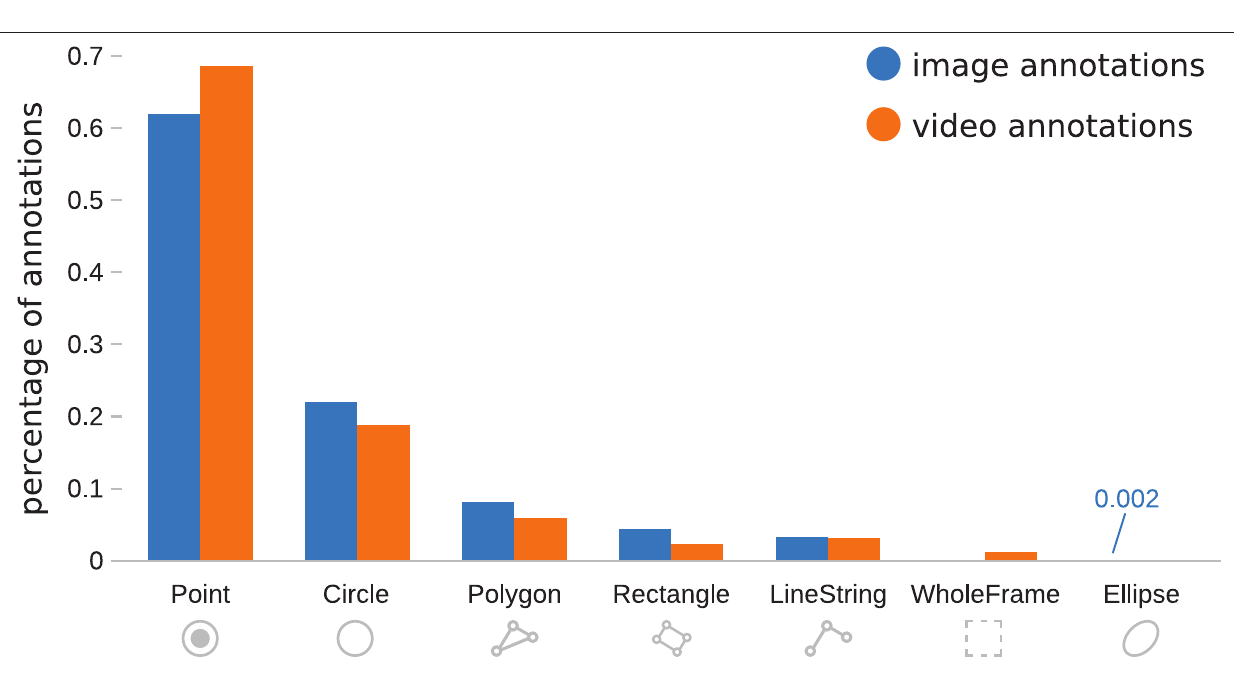
FIGURE 6 | Number of users grouped by the number of image and video annotations they have created on biigle.de. Out of a total of 1,061 users who have ever logged in, 518 (49%) have created at least one annotation. Half of these have created more than 205 annotations. No user has created more than 10 6 annotations.